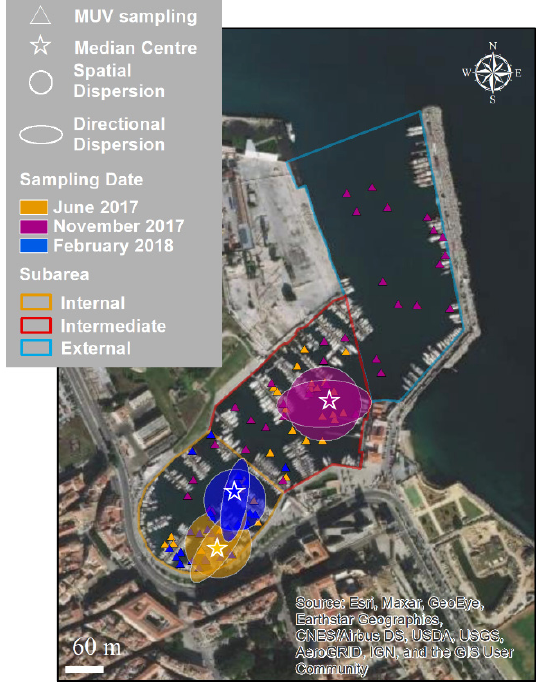
Figure 8. Key characteristics of the distribution of Cassiopea andromeda in Cala: central tendency (as a